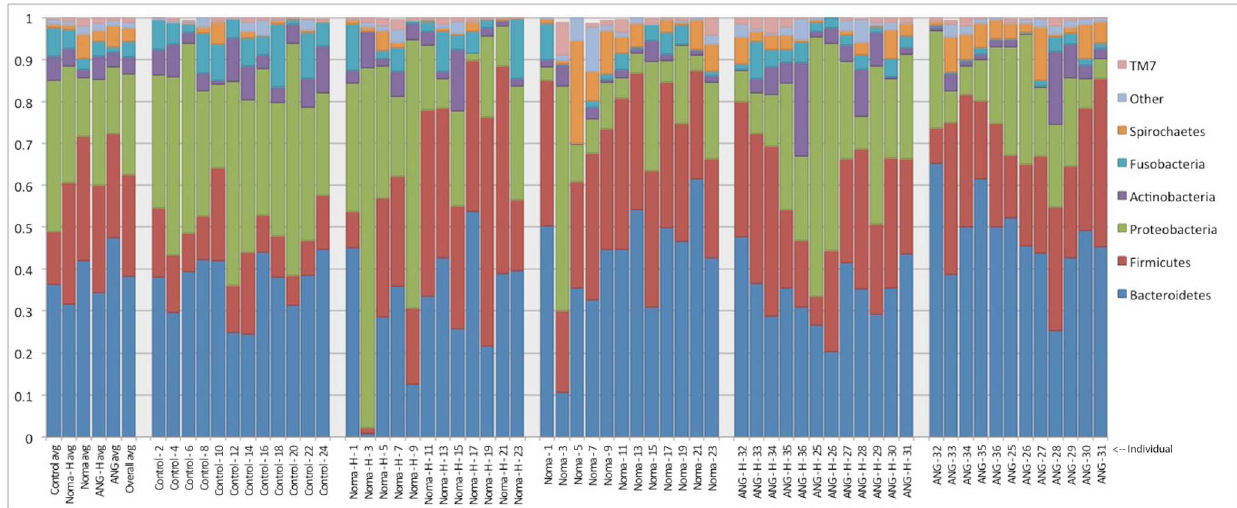
Figure 1. Abundance of Phyla across samples. The abundances of seven major bacterial phyla averaged across all samples of a given type (furthest panel on left), or for each individual sampled (five panels to the right). The y-axis indicates the proportion of each phylum.